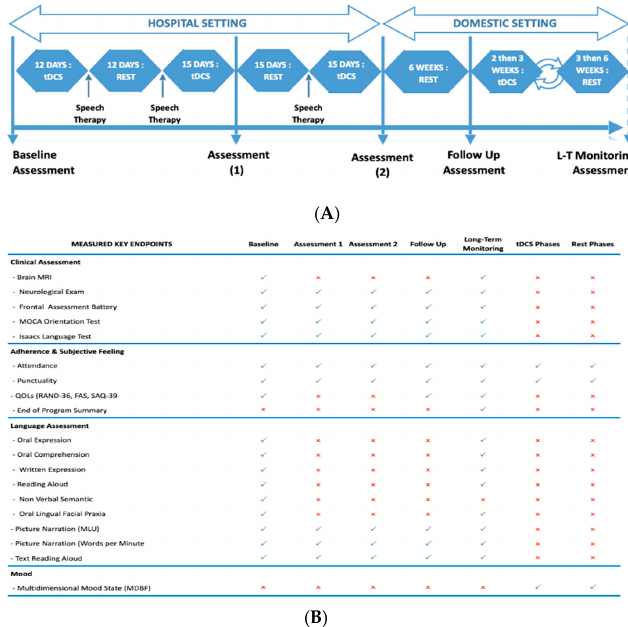
Figure 1. ( A ) Design of the study. ( B ) Measured key